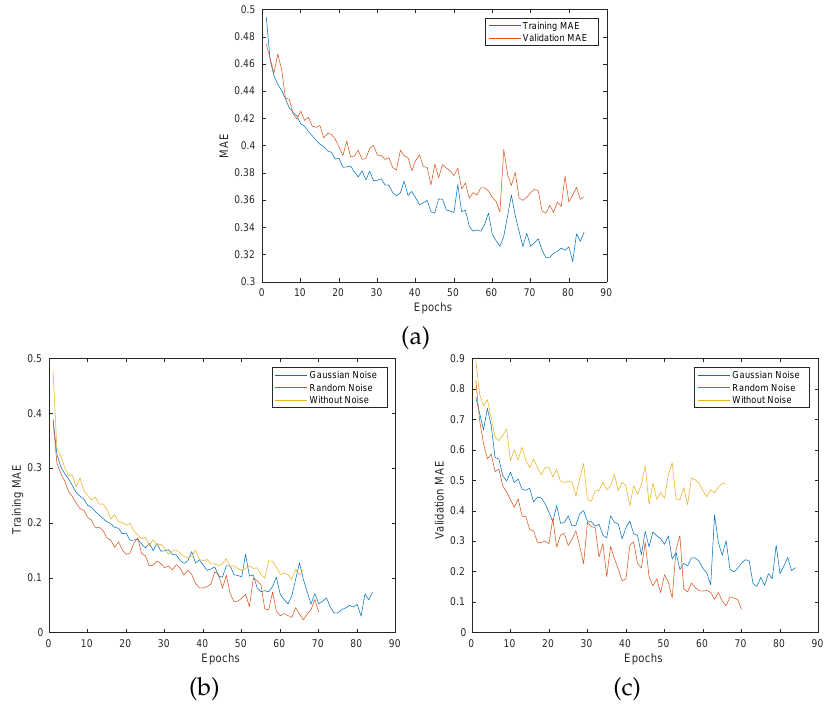
Figure 8. The MAE of proposed model, ( a ) shows the training and validation MAE for the model with Gaussian noise, ( b , c ) show the comparative validation and training MAE with a different configuration of